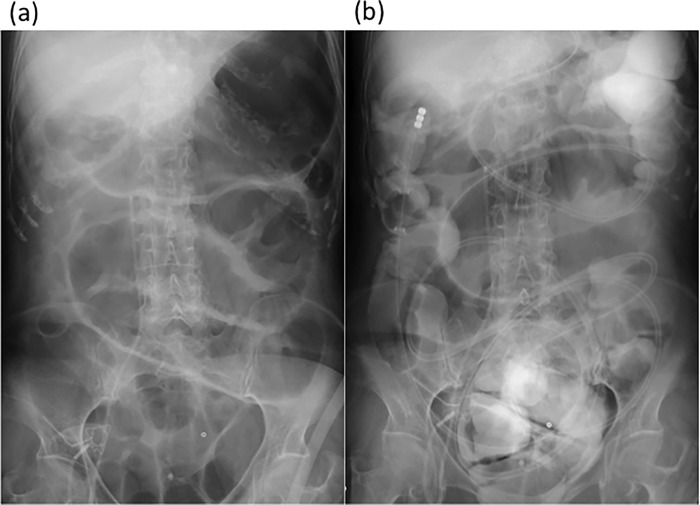
Radiological improvement after insertion of ileus tube.Abdominal radiograph on admission in a patient with adhesive small bowel obstruction (a) compared with the radiograph obtained 1 day after ileus tube decompression (b). The previous gas-filled or fluid-filled small bowel loops showed no evidence of distension, the air–fluid levels disappeared, and the tip of the ileus tube reached the colon.